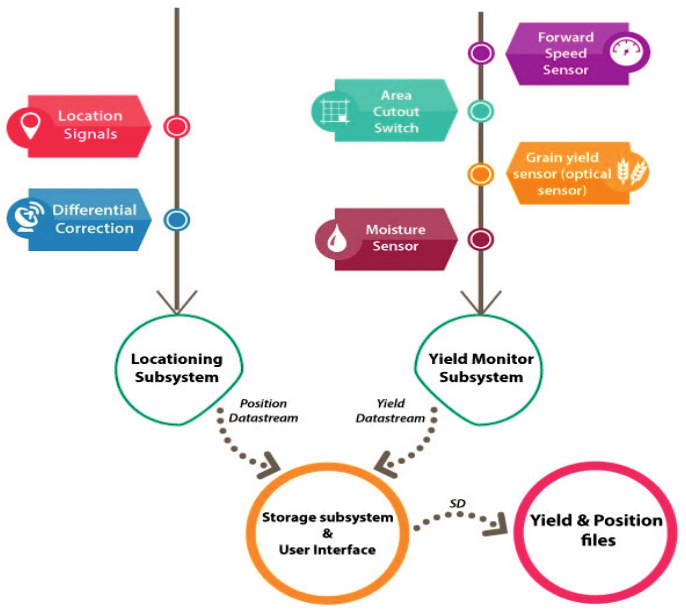
Figure 2. A block diagram of the yield monitoring system